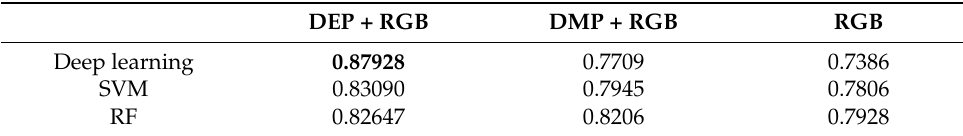
Table 3. Kappa coefficient for Pleiades dataset.